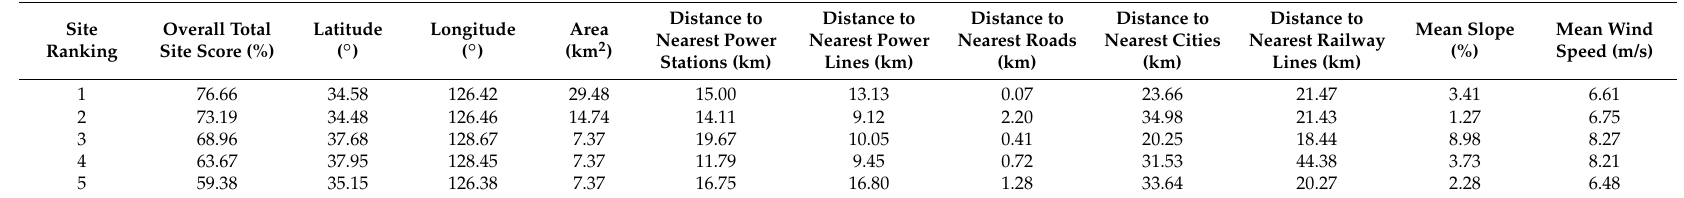
Table 13. Details of Top 5 wind farm sites in South Korea (Scenario 1).